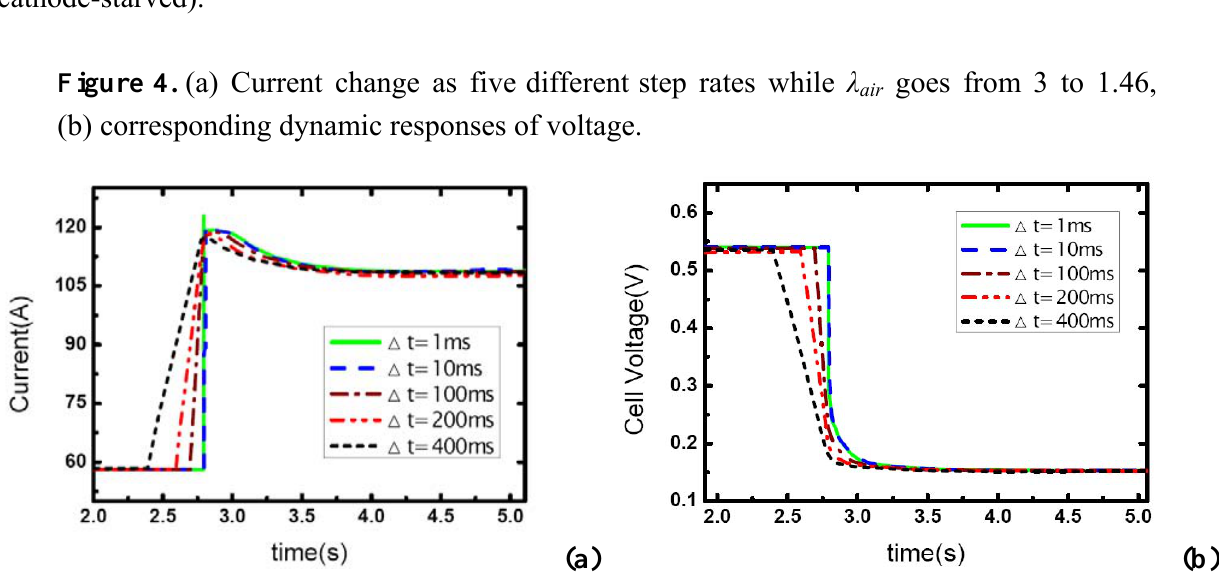
goes from 3 to 1.46, air